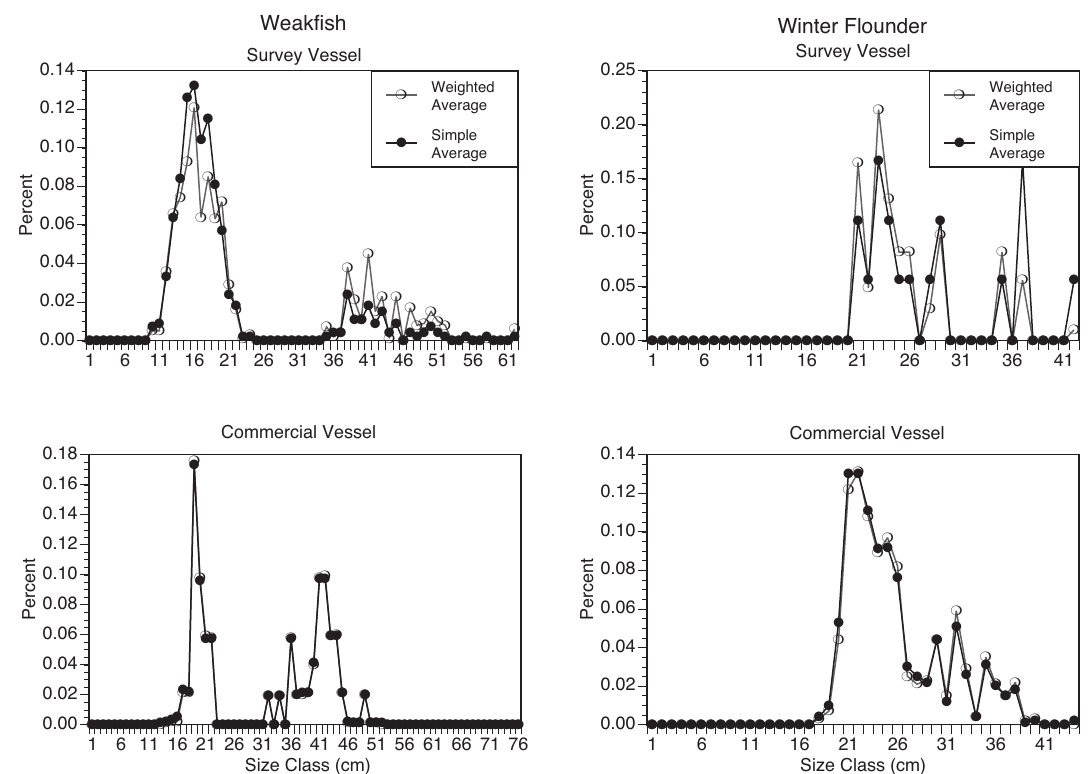
F IG . 4. – Comparison of the domain-weighted size-frequency distribution and the size-frequency distribution obtained by a simple compilation of the data for weakfish and winter flounder for the survey vessel and the commercial vessel. T ABLE 3. – Ratio of mean catches in the commercial and survey ves- sel tow series for the four size classes defined in Tables 4 and 5, cal- culated as